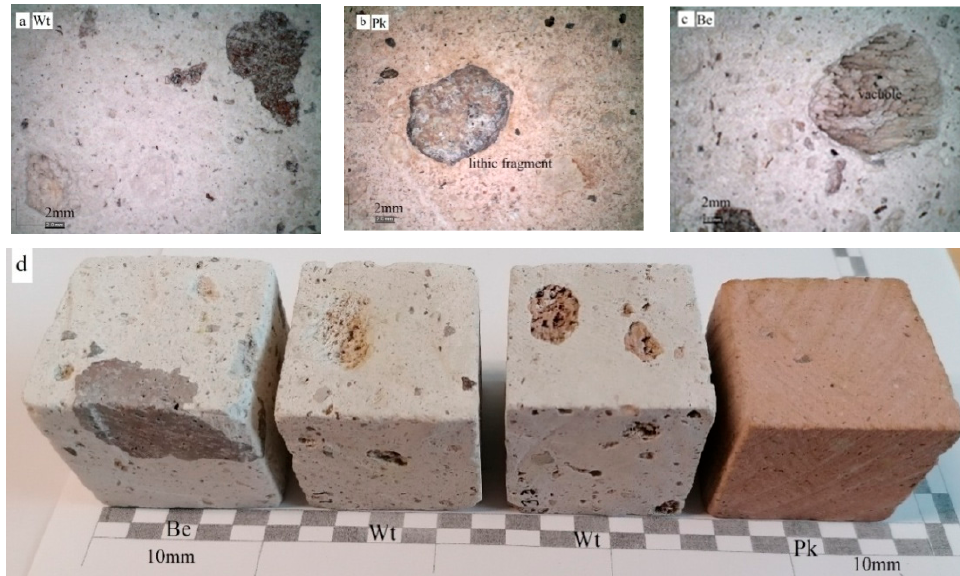
Figure 3. ( a , b ) Intrusions; ( c ) vacuole with acicular pumice; ( d ) surface appearance of Be ignimbrite with edge intrusion, two Wt ignimbrites with filled vacuoles of different colored fibbers and Pk ignimbrite without vacuoles (from left to right).